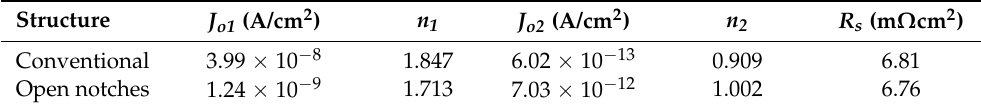
Figure 5. A comparison between the local ideality factor, derived from the dark J-V characteristics, of the conventional and modified structures. 3.2. ARC Techniques In this subsection, the impact of various ARC schemes on the proposed npn SC mi- crostructure performance is investigated. Remarkably, antireflection coating techniques play a crucial role in decreasing the front surface reflectivity. Such techniques could be significantly efficient in enhancing the optical performance of SCs, especially silicon- based cells, due to the high refractive index of silicon [36,37]. Here, single, double, and triple ARC layers are simulated to achieve minimum reflectivity and maximum available photocurrent. As a result, the conversion efficiency will be maximized. The main perfor- mance indicators, like reflectivity, as well as available and source photocurrents, are sim- ulated and provided to give a comparative study between the different cases of ARCs. Firstly, the effect of using a single ARC layer of ZnO is carried out. The ZnO is se- lected as it achieves lower reflectivity in a wider band of the wavelength in comparison with the other single-layer ARCs [55,56]. The thickness of the ZnO ARC single layer is selected to be 64 nm, which is the optimum design condition [55–57]. Secondly, a double